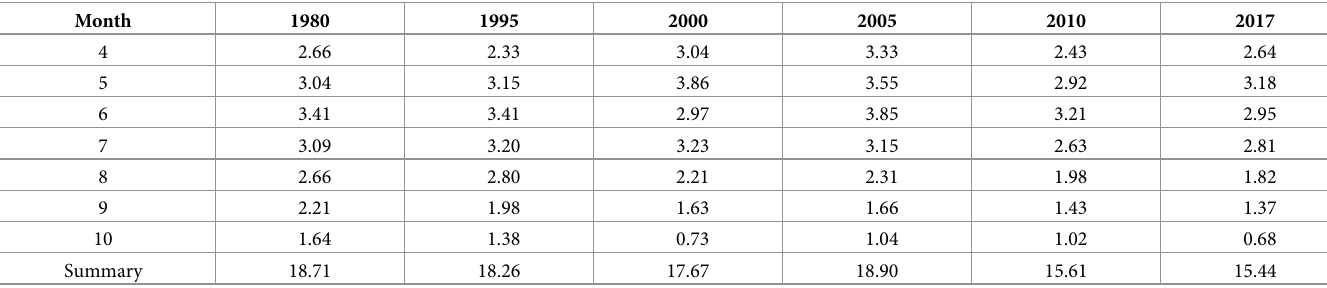
Table 6. WFs of grassland from April to October in different years (billion